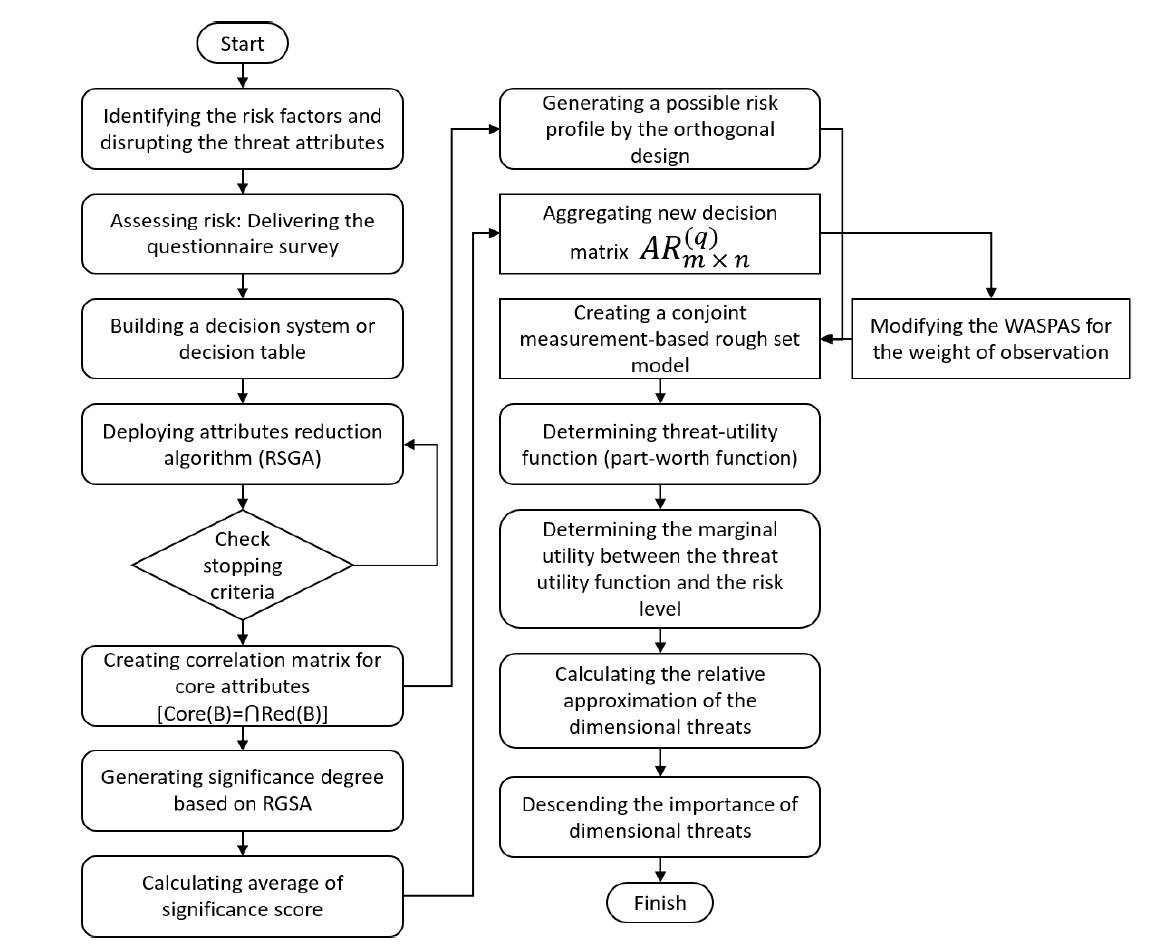
Figure 1. Flowchart of the threat utility.